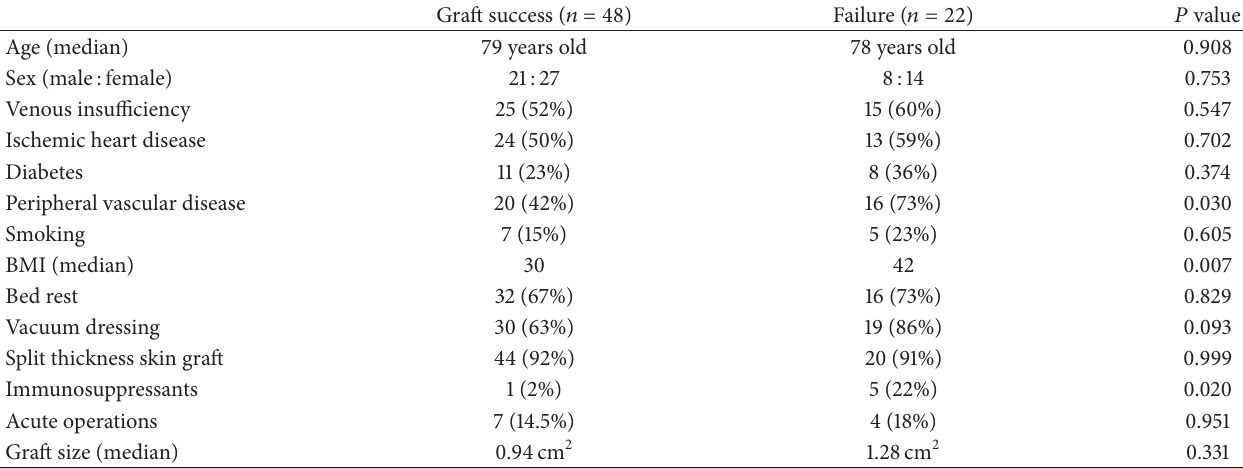
Table 3: Analysis of success grafts versus failed grafts, data presented as ( 𝑛 , %) unless otherwise